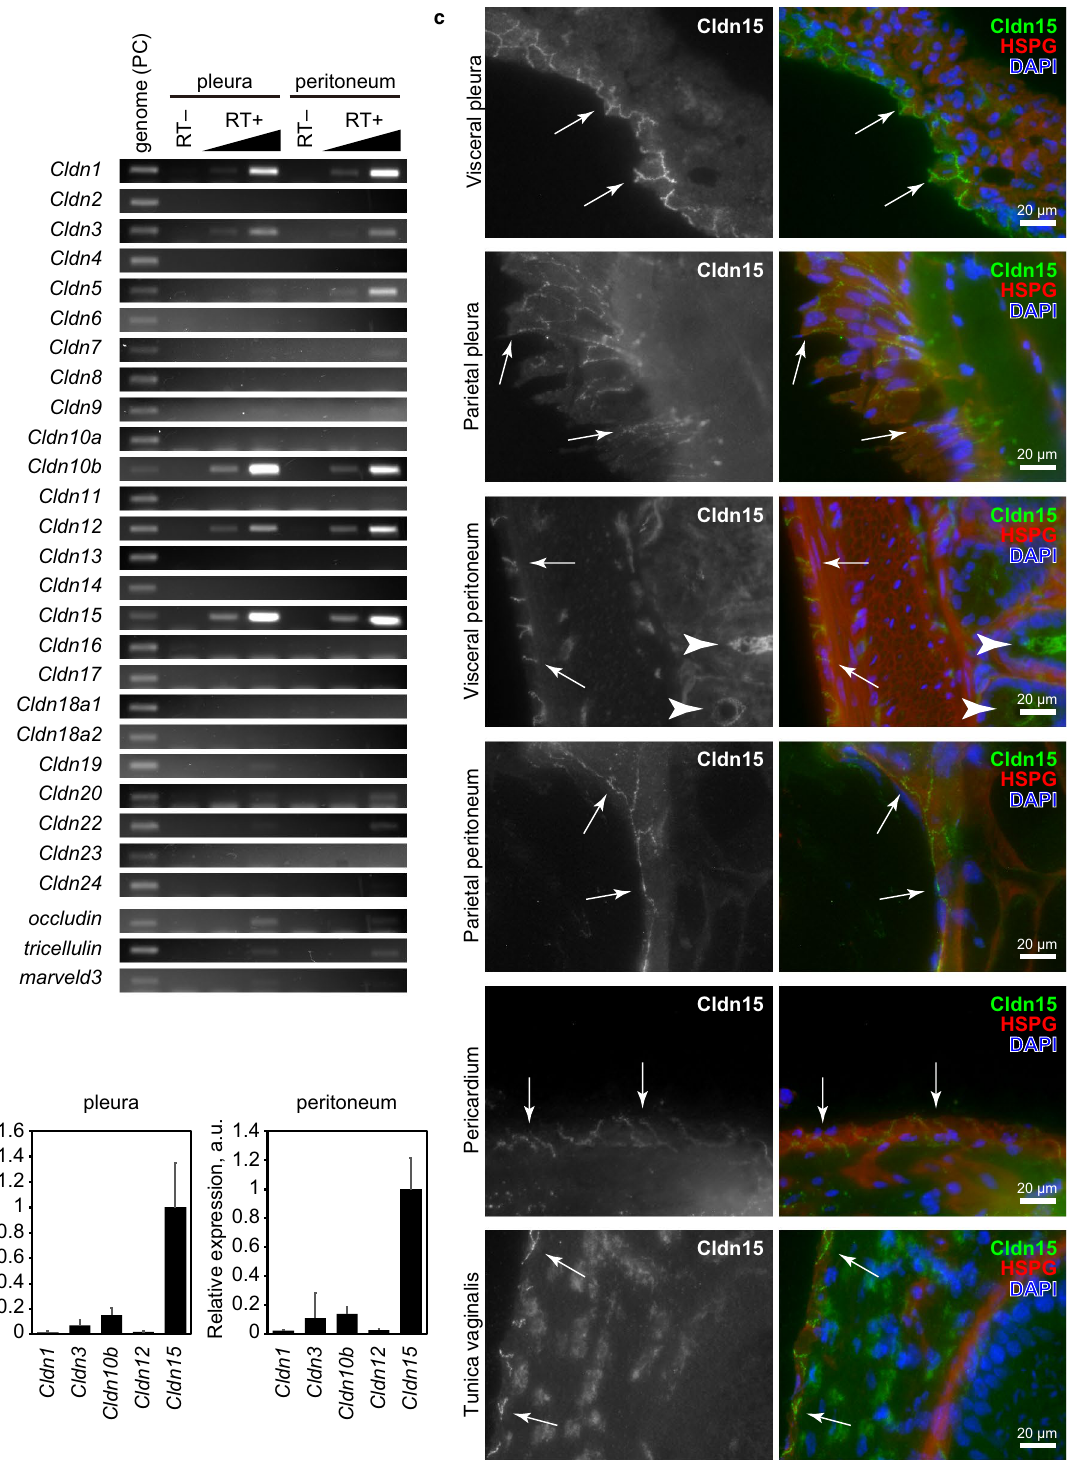
Figure 1. Claudin-15 is the major constituent of mesothelial tight junctions. a RT-PCR of mouse pleura and peritoneum using specific primers for claudins. Note that claudin-1, -5, -10b, -12 and -15 are expressed in the mesothelial tissues and that tight junction markers occludin and tricellulin are also expressed. Genomic DNA and samples prepared without reverse transcriptase were used as positive and negative controls, respectively. b Real-time RT-PCR of claudins. The relative expression levels were calculated using purified DNA fragments of each claudin as a standard. Note that claudin-15 is most abundantly expressed in both the pleura and peritoneum samples. c Immunofluorescence staining of mesothelial tissues. Visceral and parietal pleura, visceral and parietal peritoneum, pericardium, and tunica vaginalis were stained for claudin-15 (green), HSPG (basement membrane marker, red) and DAPI (DNA, blue). Note that claudin-15 is localized at cell–cell junctions of mesothelial